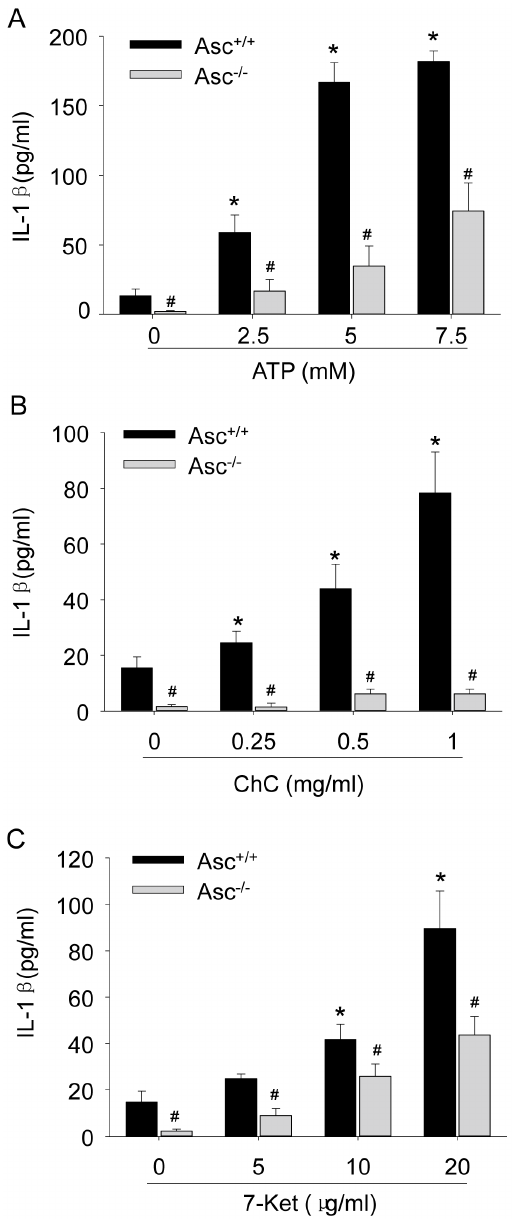
Figure 3. Effects of ATP, cholesterol crystals and 7-Ketocho- lesterol on IL-1 b production in Asc + / + and Asc 2 / 2 BMMs. BMMs were stimulated with ATP (0–7.5 mM) (A), cholesterol crystals (CHC, 0– 1 mg/ml) (B) or 7-ketocholesterol (7-Ket, 0–20 m g/ml) (C) for 16 h and IL-1 b concentrations in the supernatants were determined by ELISA. * P , 0.05 vs . untreated Asc + / + control group; # P , 0.05 Asc 2 / 2 vs . Asc + / + group (n=6).